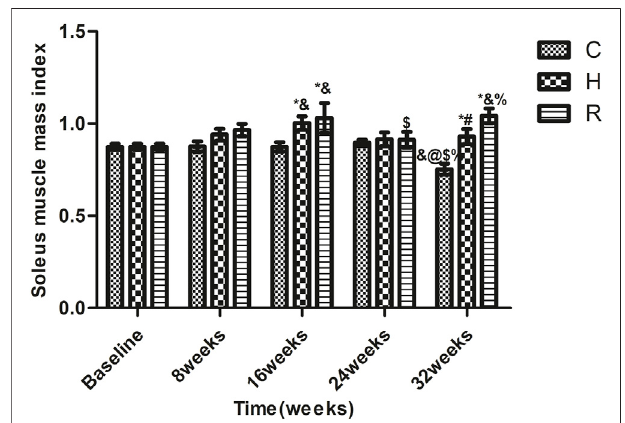
FIGURE2| Thesoleusmuscle fi berCSAofratsineachgroup.*Signi fi cant different from C and other group; # Signi fi cant different from H and R; & Signi fi cant different from Baseline and other weeks; @ Signi fi cant different from 8 weeks and otherweeks; $ Signi fi cant different from 16 weeks and other weeks; % Signi fi cant different from 24 weeks and other weeks ( p < 0.05).